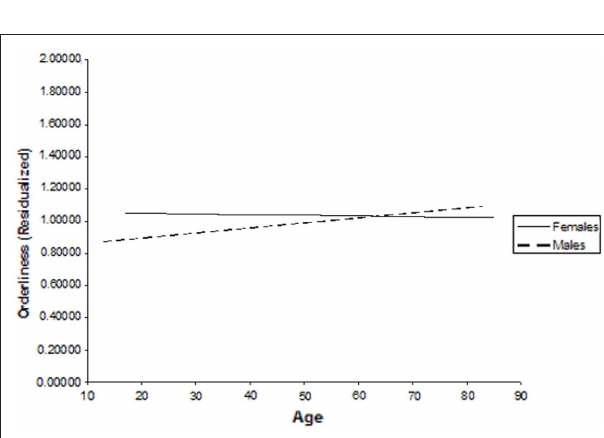
FIguRE 7 | Age moderates gender differences in Intellect.